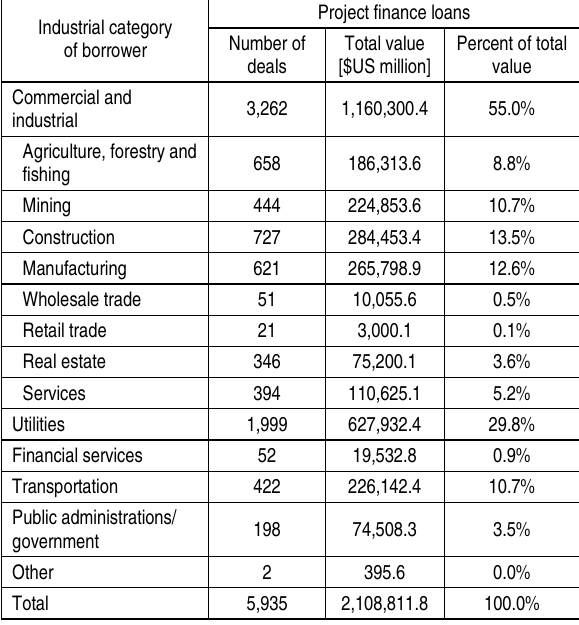
Table 2. Industrial distribution of the sample of